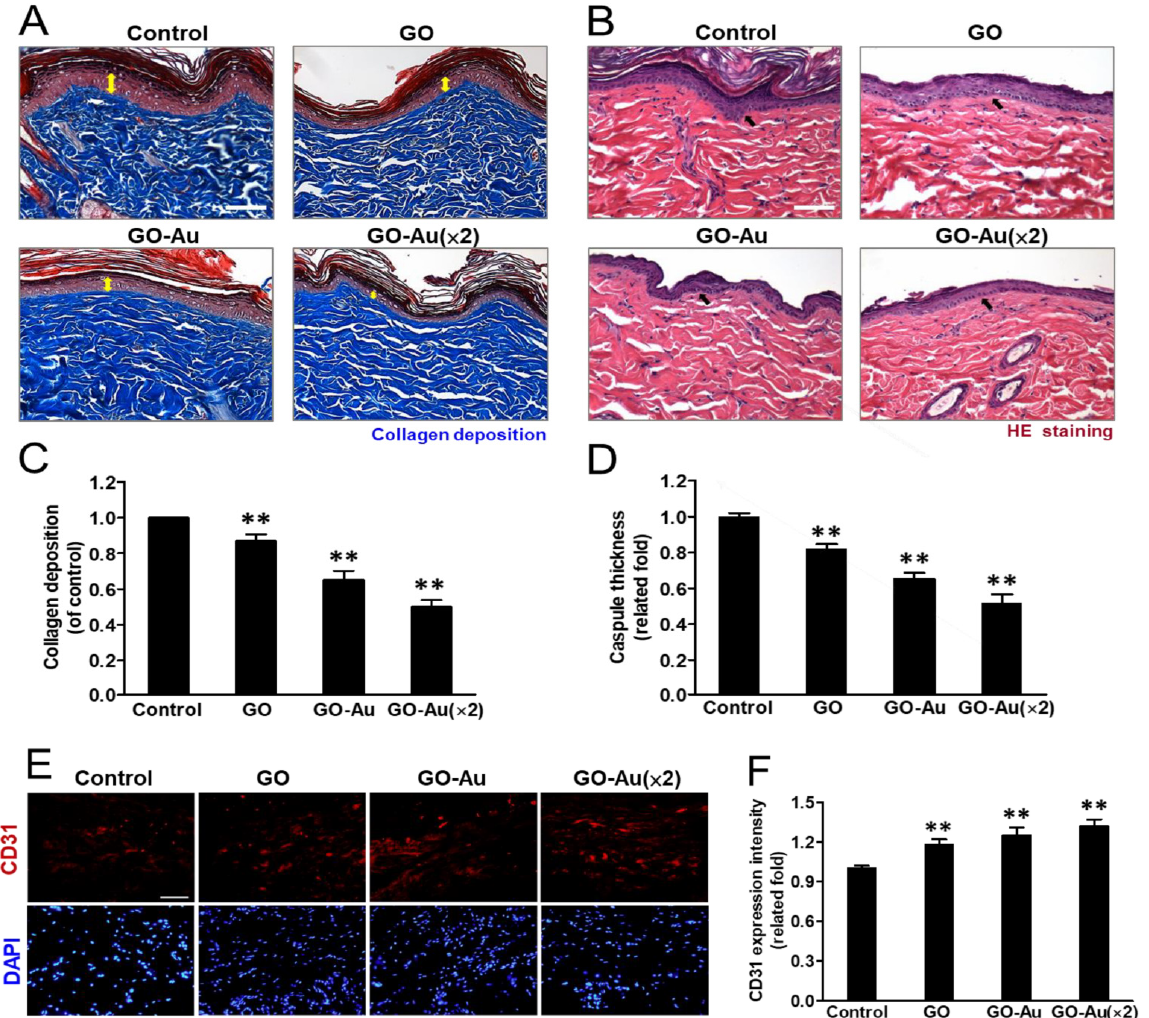
Figure 8. Histological analysis of foreign-body response (FBR) of different materials following four-week subcutaneous implantation. Photomicrographs showing ( A ) the Masson’s trichrome-stained histological sections and ( B ) the hematoxylin and eosin (H&E)-stained histological sections of as-prepared nanocomposites. ( C ) Quantification of collagen deposition (yellow double arrow in panel A) on the histology examination. ( D ) Analysis of the FBR was revealed with the capsule thickness (arrows in panel B) based on the histology examination. Scale bar = 100 µ m. Data were presented as the mean ± SD ( n = 6). ** p < 0.01 as compared with the control group. Immunohistochemical analysis of endothelialization. ( E ) Immunofluorescent staining of explanted nanocomposites of GO, GO-Au, and GO-Au ( × 2) with surrounding tissue were stained for endothelialization marker of CD31. Cell nuclei were stained with DAPI (blue). Scale bar = 20 µ m. ( F ) The fluorescence intensity of CD31 was quantified and recorded. Data were presented as the mean ± SD ( n = 6). ** p < 0.01 as compared with the control